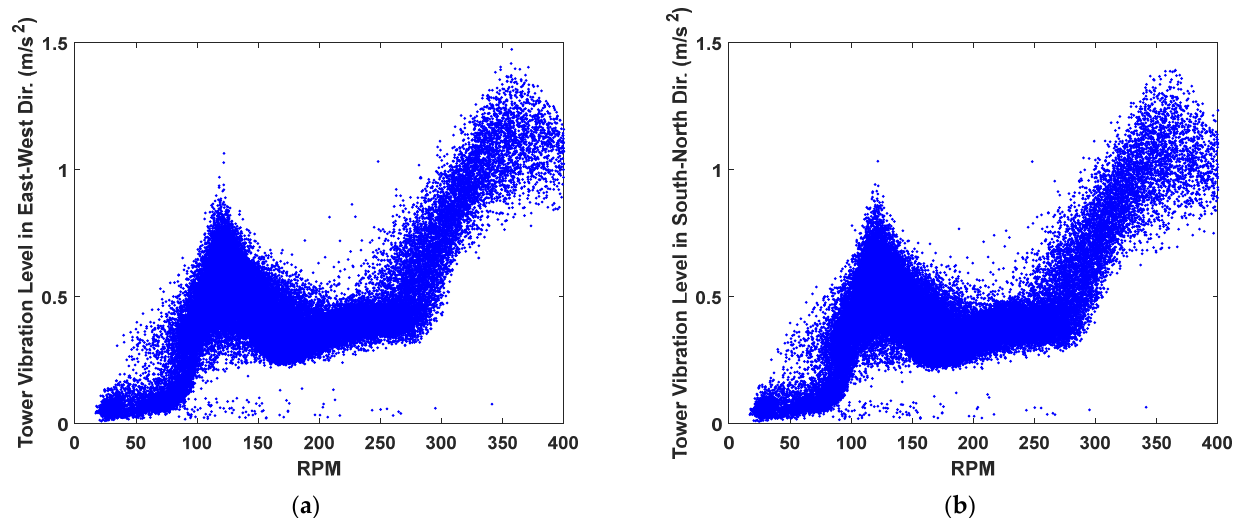
Figure 7. RMS values of the tower vibration for each 1-minute data set: ( a ) vibration level in the east—west direction, a T , EW ; ( b ) vibration level in the south—north direction, a T , SN